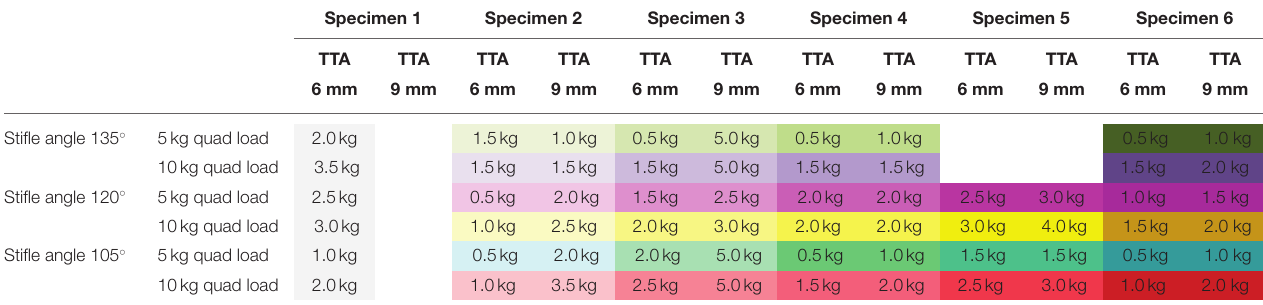
TABLE 1B | The change in the pes load prior to failure with increasing tibial tuberosity